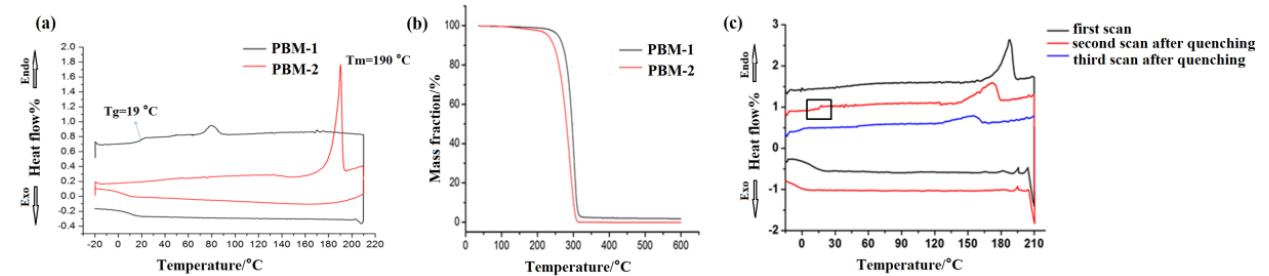
Figure 5. DSC and TG spectra of PBM. ( a ) DSC spectra; ( b ) TG spectra; ( c ) DSC spectra of PBM-2.